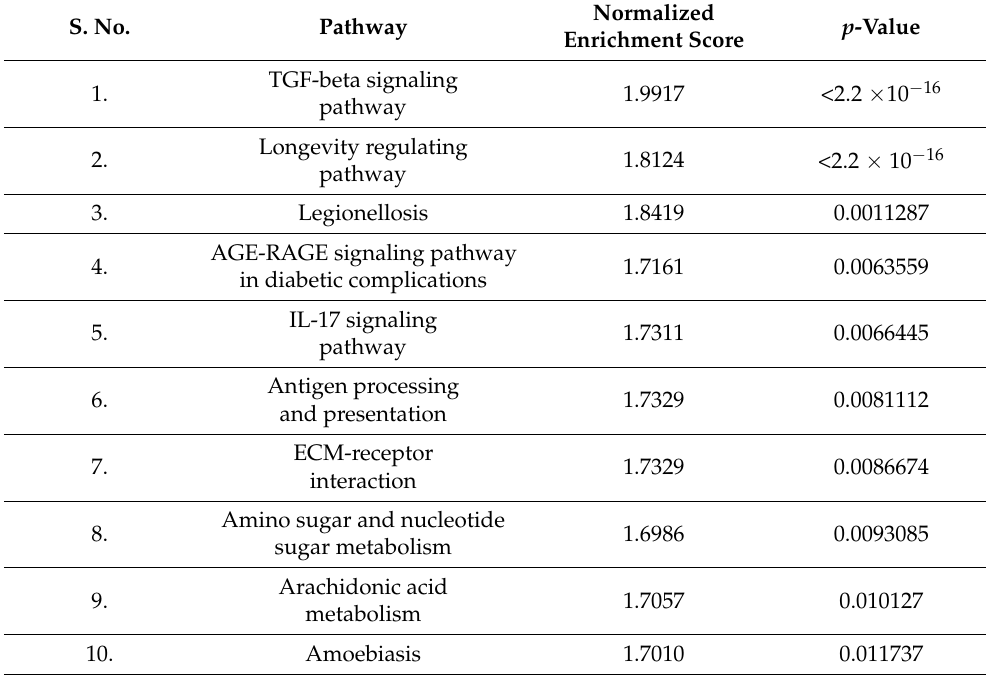
Table 1. The significantly enriched pathways in PLA2G2A+ IPF fibroblasts. S.